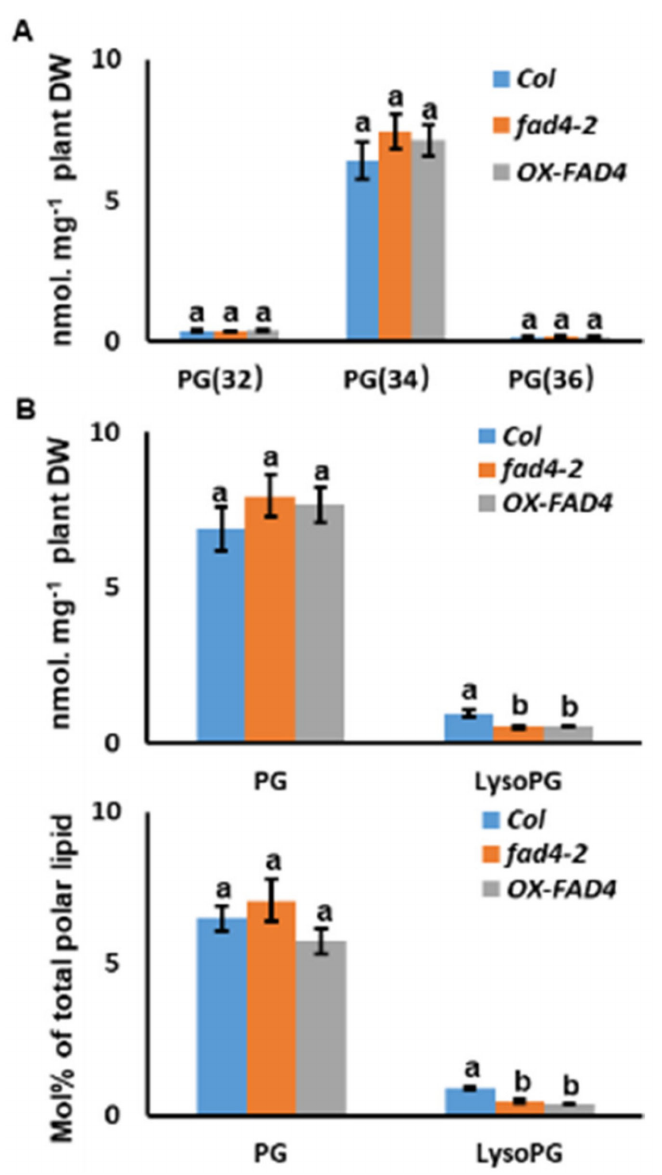
Figure 7. PG and LysoPG contents and Mol % distribution from total polar lipids of WT, fad42 , and OXFAD4 plants. ( A ). The pool size of PG(32), PG(34), and PG(36) of WT, fad42 , and OXFAD4_2 plants. ( B ). The PG and lysoPG contents (upper panel) and Mol% distribution from total polar lipids (lower panel) of WT, fad4-2 , and OX - FAD4_2 plants. Different letters within same chemical class represent statistically significant